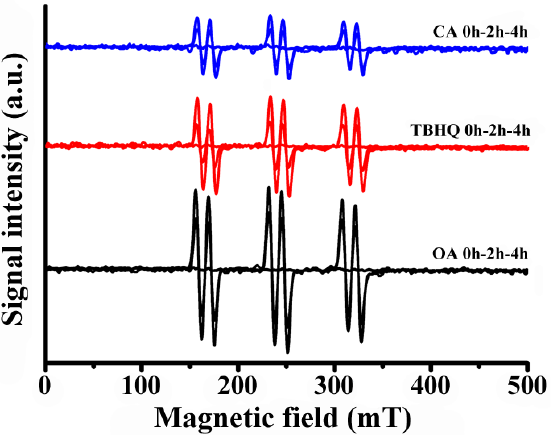
Figure 5. ESR spectra of PBN-free radical adducts over OA with and without CA and TBHQ under thermal oxidation for 0 h, 2 h, 4 h, respectively. thermal oxidation for 0 h, 2 h, 4 h,